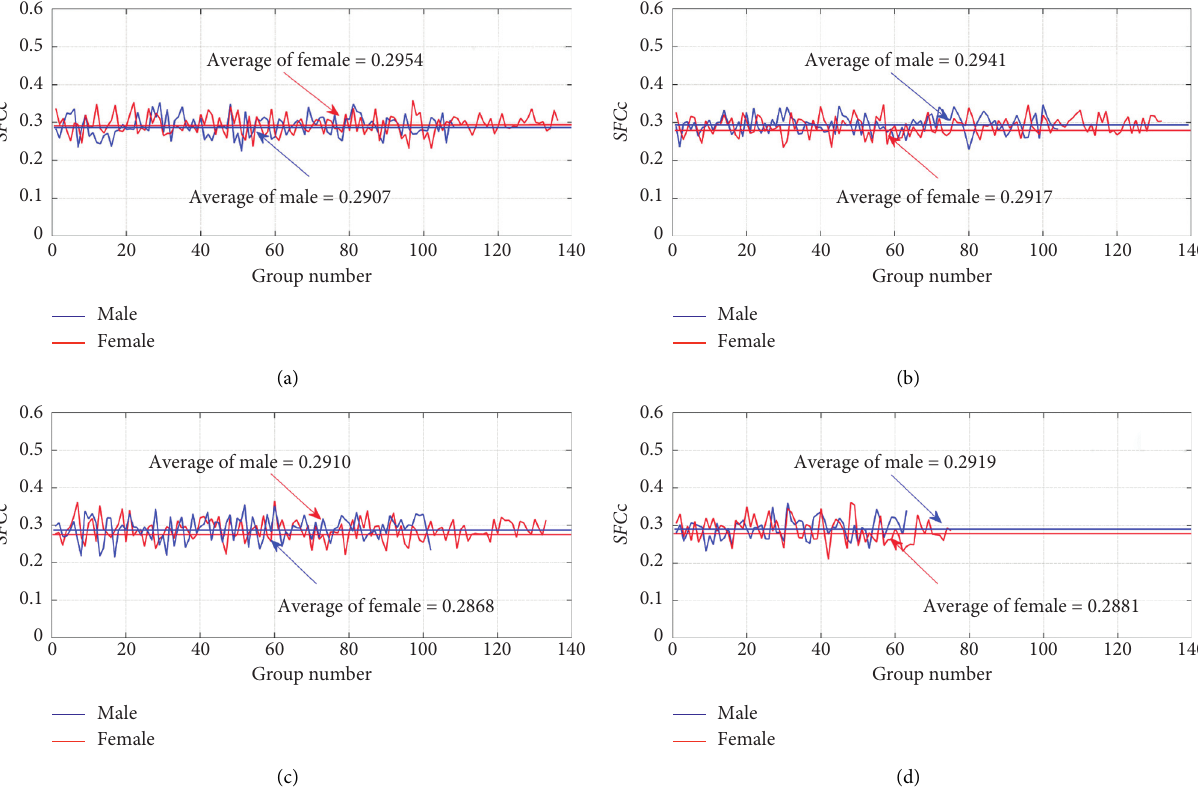
Figure 7: The SFC c of different gender group. (a) Section 2. (b) Section 3. (c) Section 4. (d) Section 5.